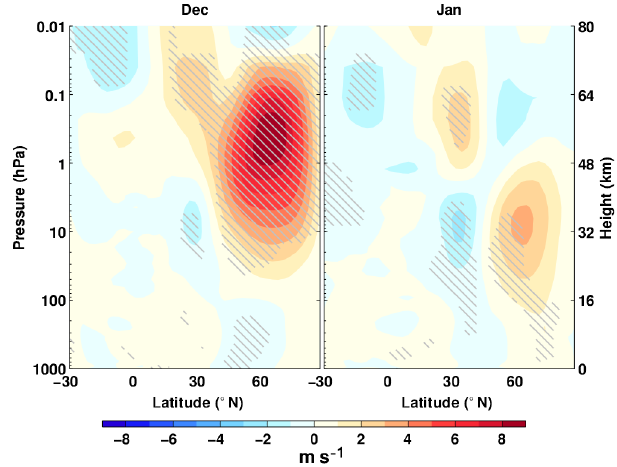
Figure 10. Zonal mean zonal wind response to the 11-year solar cy- cle according to CMIP6-SSI in December and January as “ensemble mean” of CESM1(WACCM) and EMAC simulations; hatched areas denote statistical significance ( p < 5%) of shown differences.